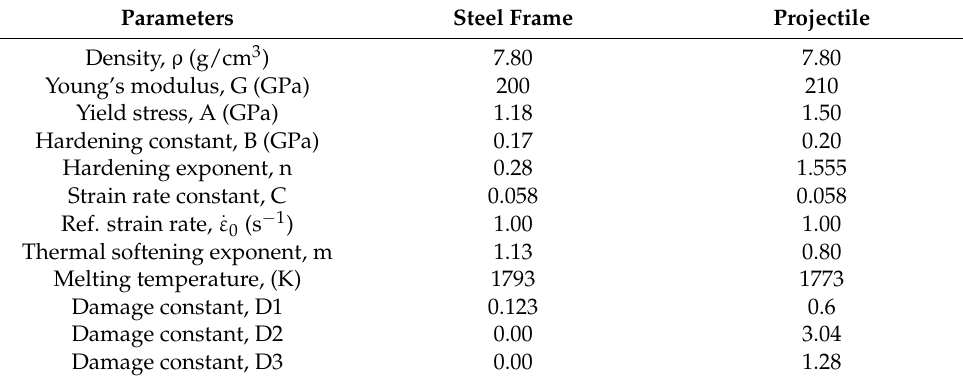
Table 3. Johnson–Cook material model parameters for the projectile and the steel frame.